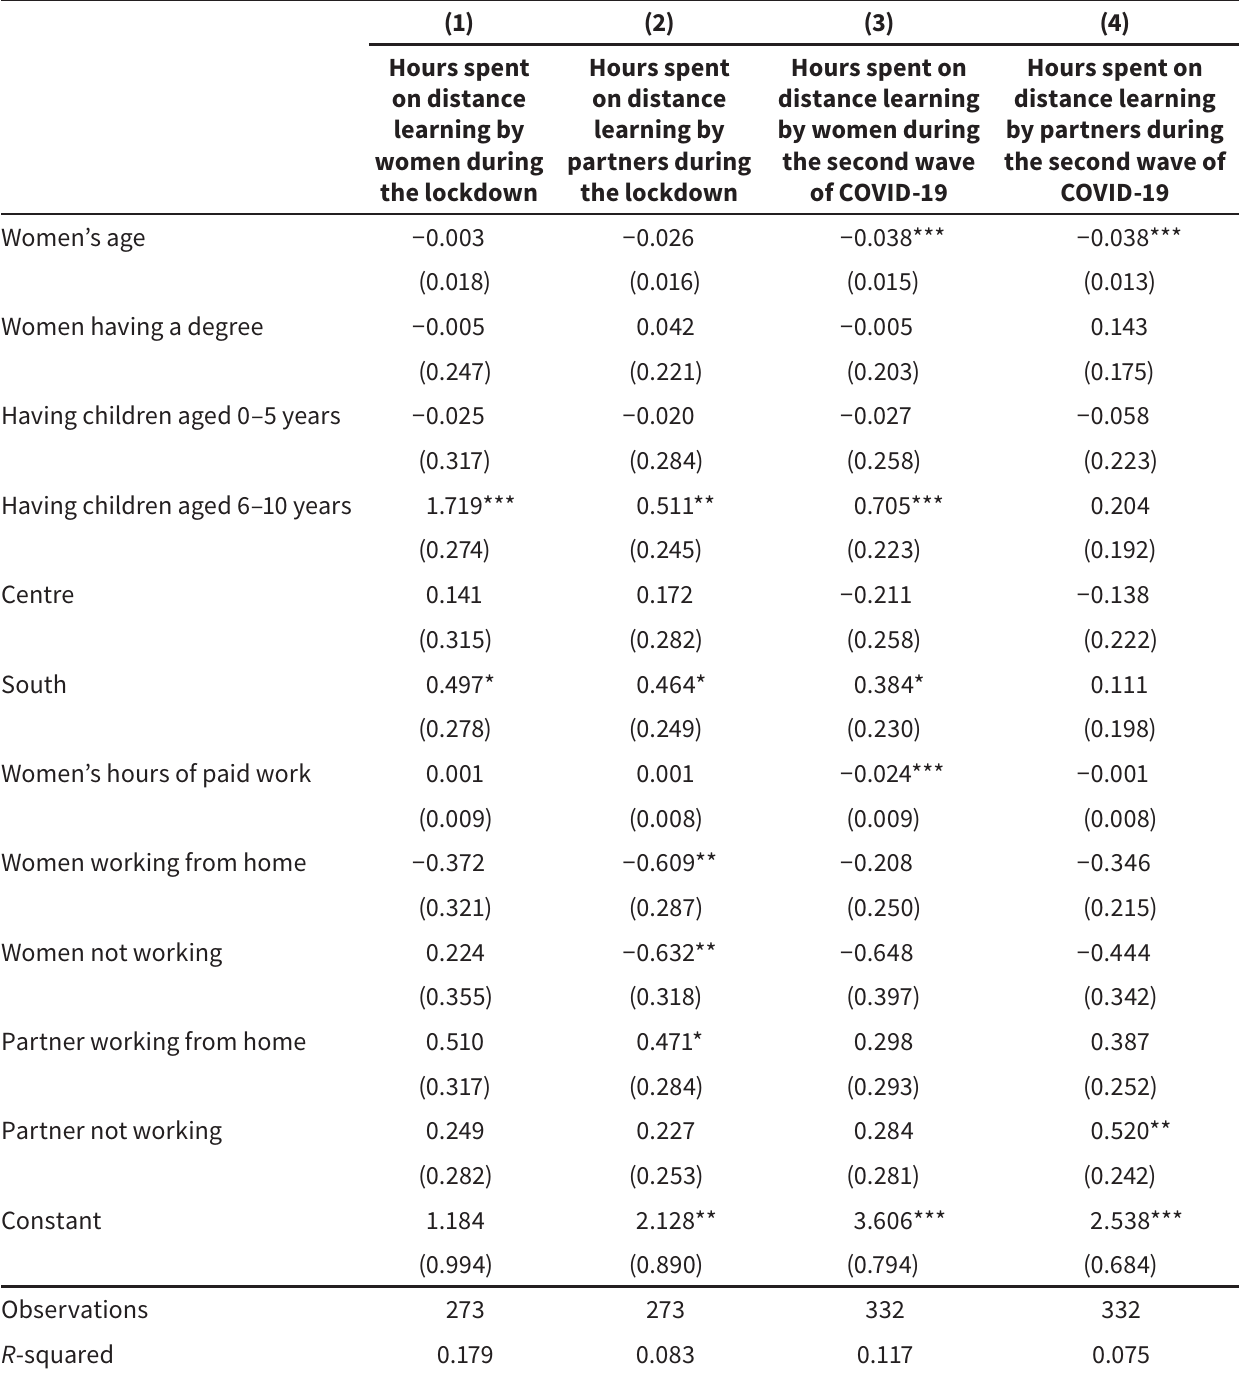
Table 5 Multivariate regression model of hours spent on helping children in distance learning by women and their partners during the first and second waves of